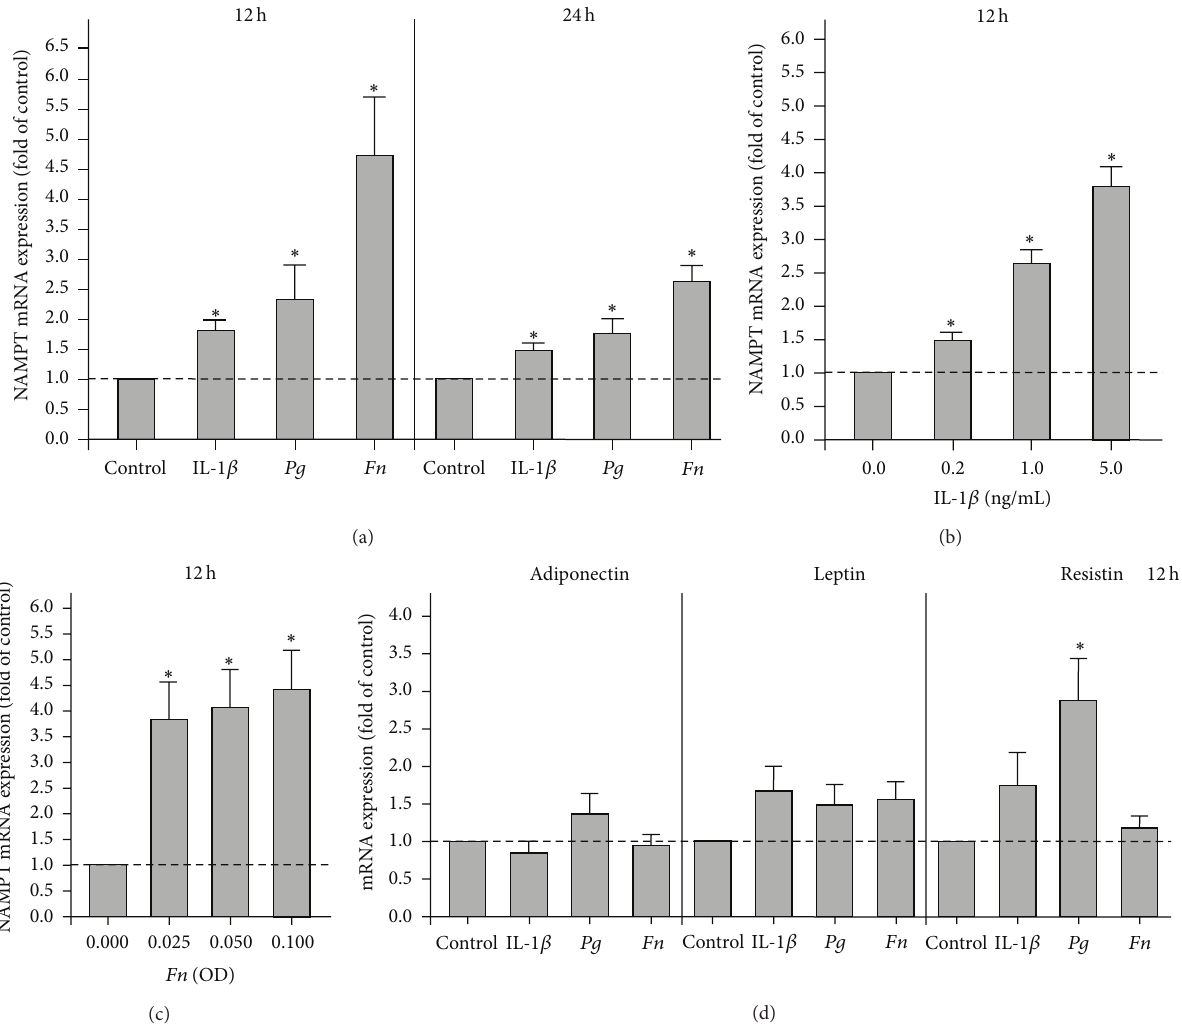
Figure 1: Expression of NAMPT and other adipokines in HGF. (a) Upregulation of NAMPT mRNA expression by IL-1 𝛽 , P. gingivalis ( Pg ), and F. nucleatum ( Fn ) in HGF from 8 donors at 12h and 24 h. (b) Stimulation of NAMPT mRNA expression by various concentrations (0.2, 1.0, and 5.0 ng/mL) of IL-1 𝛽 in HGF from 3 donors at 12 h. (c) Stimulation of NAMPT mRNA expression by various doses (OD: 0.025, 0.050, and 0.100) of F. nucleatum in HGF from 3 donors at 12 h. (d) Expression of adiponectin, leptin, and resistin in IL-1 𝛽 -, P. gingivalis- ( Pg -), and F. nucleatum- ( Fn -) treated HGF from 6 donors. Mean ± SEM; ∗ significantly ( 𝑃 < 0.05 ) different from control.